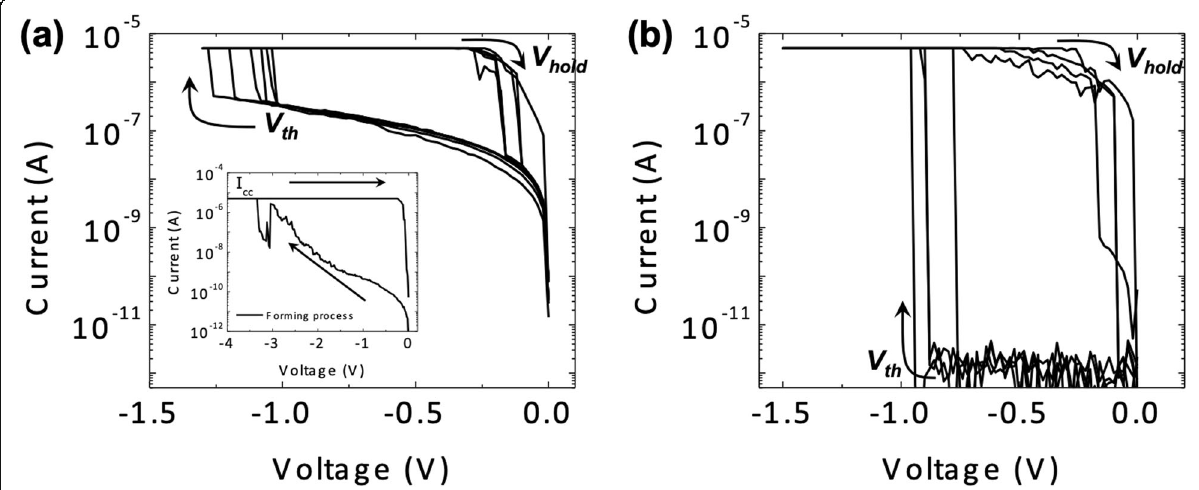
Fig. 3 Comparison of TS characteristics in D2 and D3. a TS behavior with an increased OFF current following the EF process. The inset figure shows the EF process in an as-deposited device. b TS behavior without the EF process maintaining a low OFF current and high